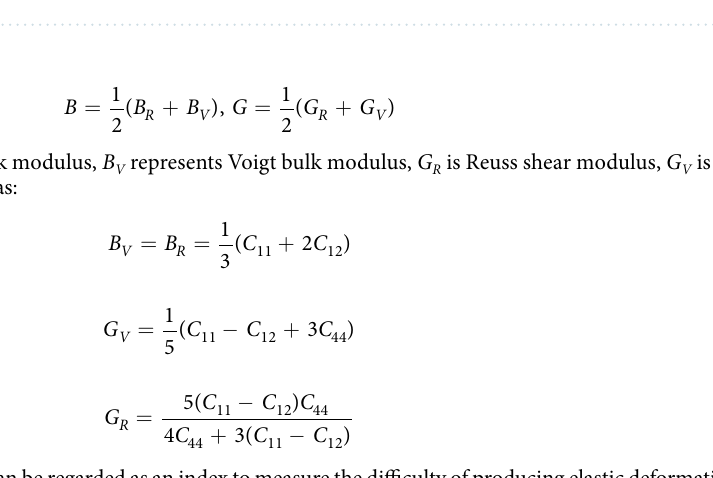
Figure 3. Bulk modulus B , shear modulus G , Young’s modulus E as a function of pressure for both B3 and B1 phases of